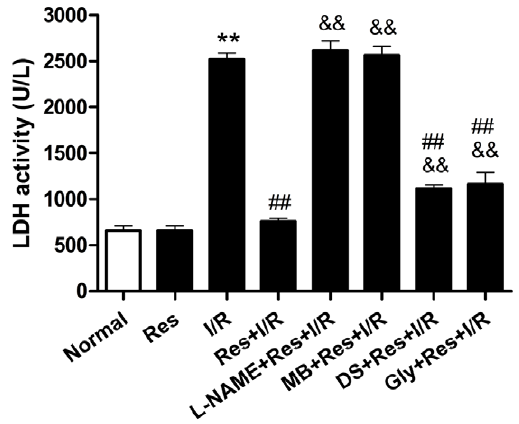
Figure 5. Effect of L-NAME, MB, DS and Gly on the cardiomy- ocytes viability in Res + I/R group. Res protected the cell viability against I/R, the role of Res on the cell viability was almost abolished by L-NAME and MB, and was significantly attenuated by DS and Gly. L- NAME, a nitric oxide synthase inhibitor; MB, Methylene blue, a cGMP inhibitor; DS, D-Sphingosine, a PKC inhibitor; Gly, Glibenclamide, a K ATP blocker. ** P , 0.01 versus the normal group. ## P , 0.01 versus the I/R group. && P , 0.01 versus the Res + I/R group. Values are the means 6 SD, n=10 in each group. doi:10.1371/journal.pone.0051223.g005 injury induced by H 2 O 2 simulation is produced by reoxygenation, Res resists calcium overload triggered by reoxygenation and serves